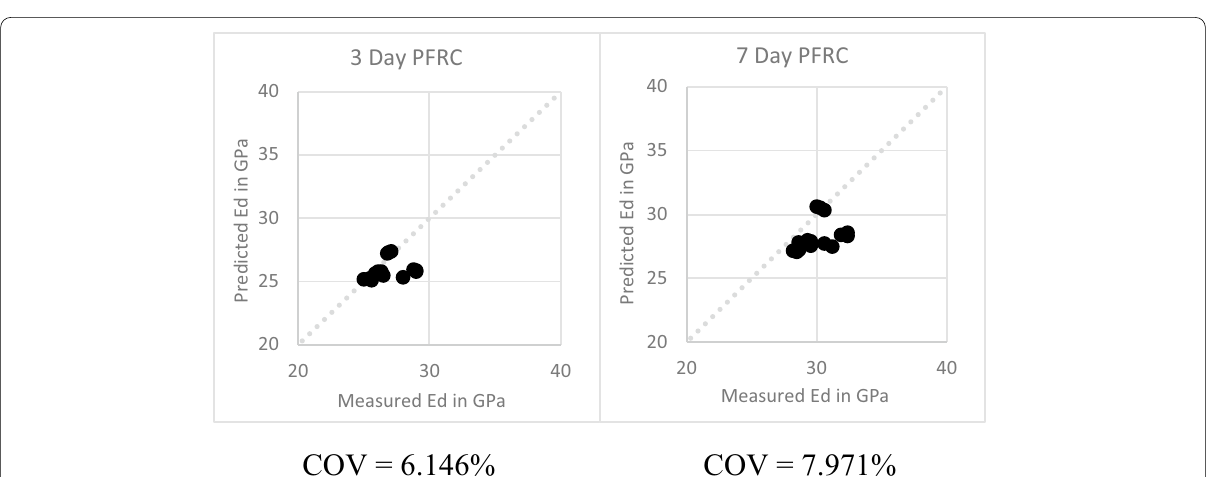
Fig. 4 Correlation between observed Ed and projected Ed for PFRC at early